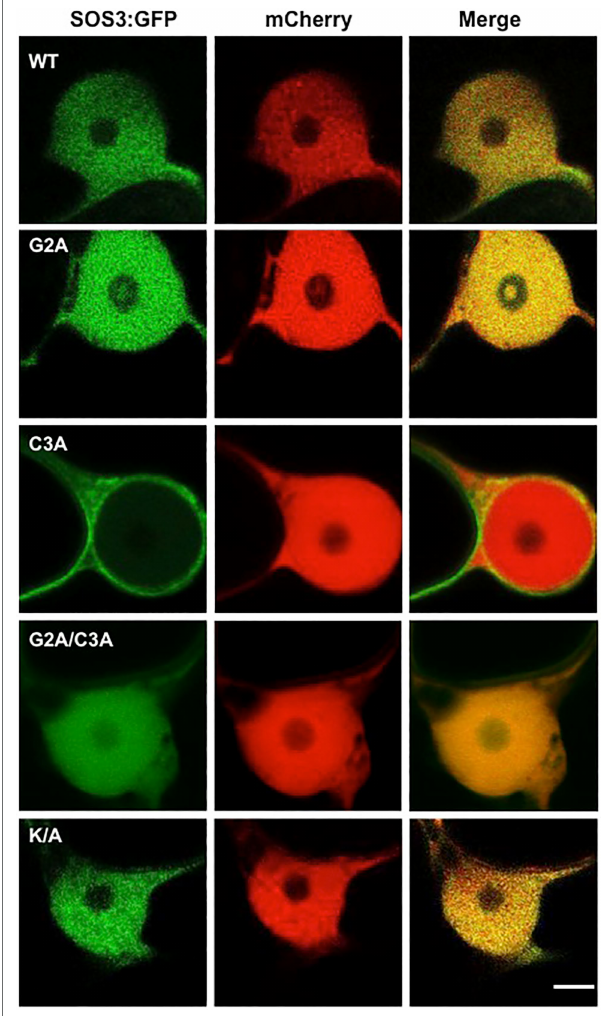
FIGURE 5 | S -acylation directs SOS3 nuclear entry. Nuclear entry or exclusion of wild-type SOS3 and mutants proteins G2A, C3A, G2A/C3A, and K/A, all fused to GFP, as shown by transient expression in N. benthamiana . The red-fluorescent protein mCherry was used as a control for nuclear localization. Scale bar = 3 μ